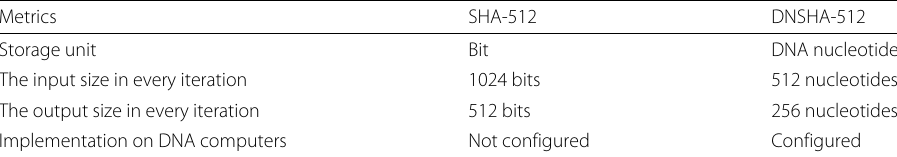
Table 7 Evaluation metrics for DNSHA-512 and SHA-512 Metrics SHA-512 DNSHA-512 Storage unit Bit DNA nucleotide The input size in every iteration 1024 bits 512 nucleotides The output size in every iteration 512 bits 256 nucleotides Implementation on DNA computers Not configured